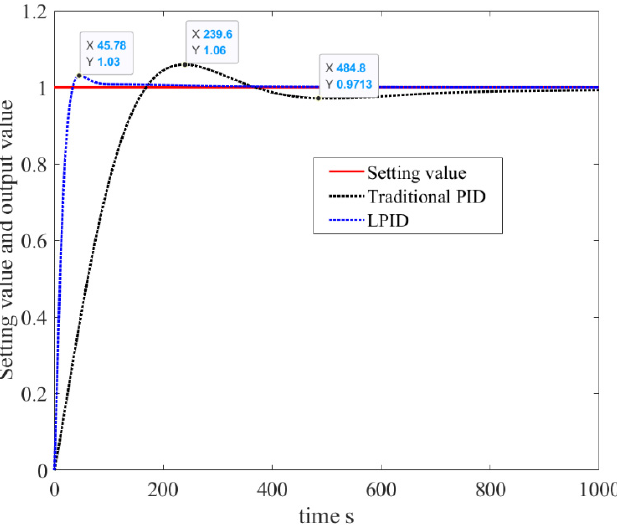
Figure 5. The Unit Step Response curve of PID and LPID.